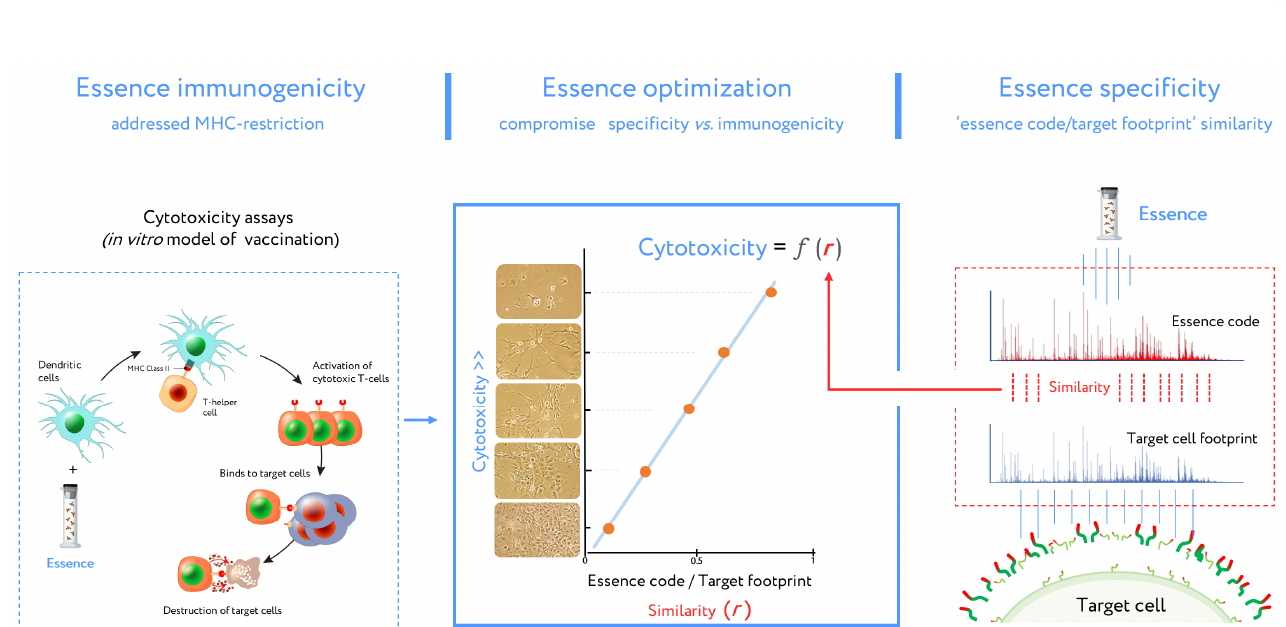
Figure 5. Stages of design for antigenic essence compositions. This vaccine development routine combines cytotoxicity assays (left plot) and target cell footprinting (right plot). In cytotoxicity assays, the dendritic cells (DCs) present essence antigens to CTLs through major histocompatibility complex (MHC). The target cell killing rate (cytotoxicity) by activated CTLs is reflected in the function describing antigenic essence efficacy from the essence/target similarity (i.e., r value). Selection of the final antigenic essence compositions involved an optimal combination of essence/target similarity and essence immunogenicity influenced by MHC restriction. Antigenic essence compositions should strike an optimal balance between similarity of essence code with the surface of target cells and enrichment of MHC-restricted peptide